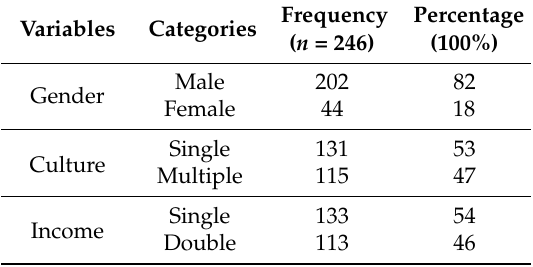
Table 1. Frequency of distributions for socio-demographic